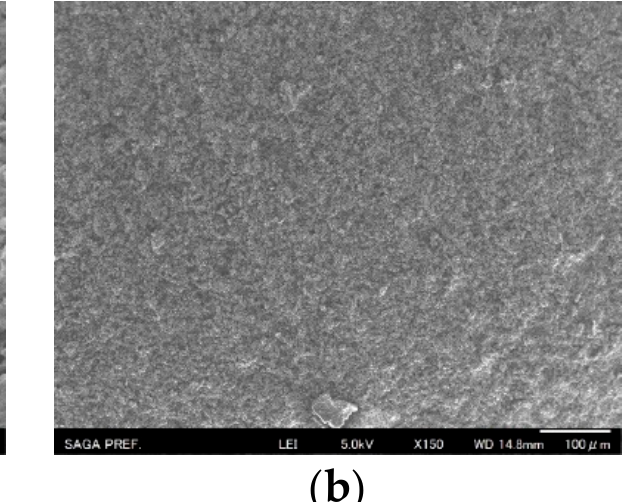
Table 7. Test results of pore distribution measurement by the mercury injection method. Wick Materials ( b ) Figure 10. Pore frequency distribution graphs ( a ) Ceramic wick ( b ) Stainless steel wick. Reproduced from [25], Saga Ce- ramics Research Laboratory: 2019. 3.1. Performance Evaluation The thermal performance can be evaluated in terms of heat flux q , heat transfer coef- ficient h e , and thermal resistances, which are evaporator R e , condenser R c , and contact sur- face R ct , as shown in Figures 11 and 12. In this study, the evaporator heat transfer coeffi-